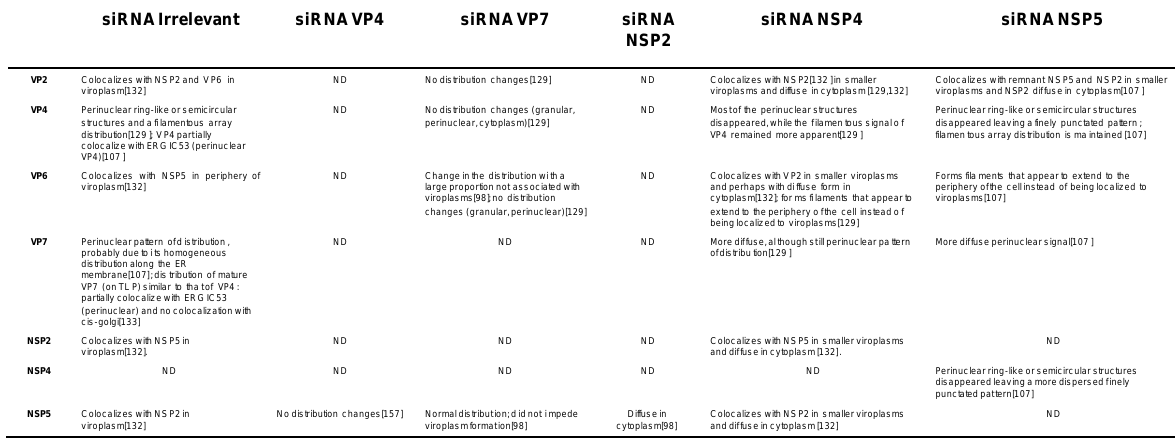
Abbreviations to Table 1A and 1B: MEP, membrane-enveloped particle; SG, stress granule; NEVP, nonenveloped viral particle; ND, not determined; other abbreviations described in